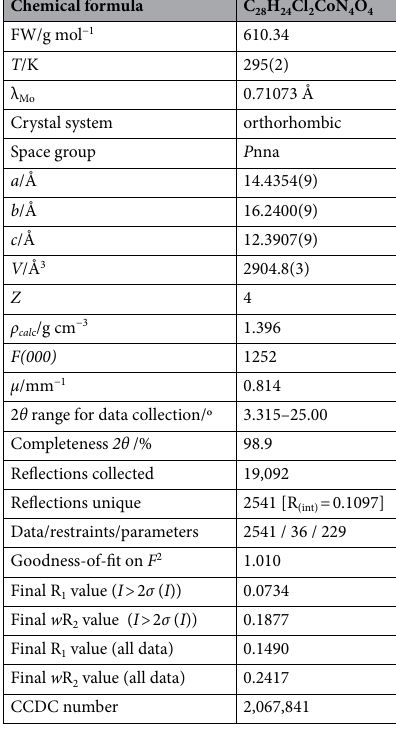
Table 1. Crystallographic data for title